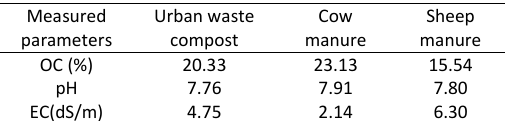
Table 2: Some chemical properties of the studied urban compost and livestock manure Table 2. Some chemical properties of the studied urban compost and livestock Measured parameters